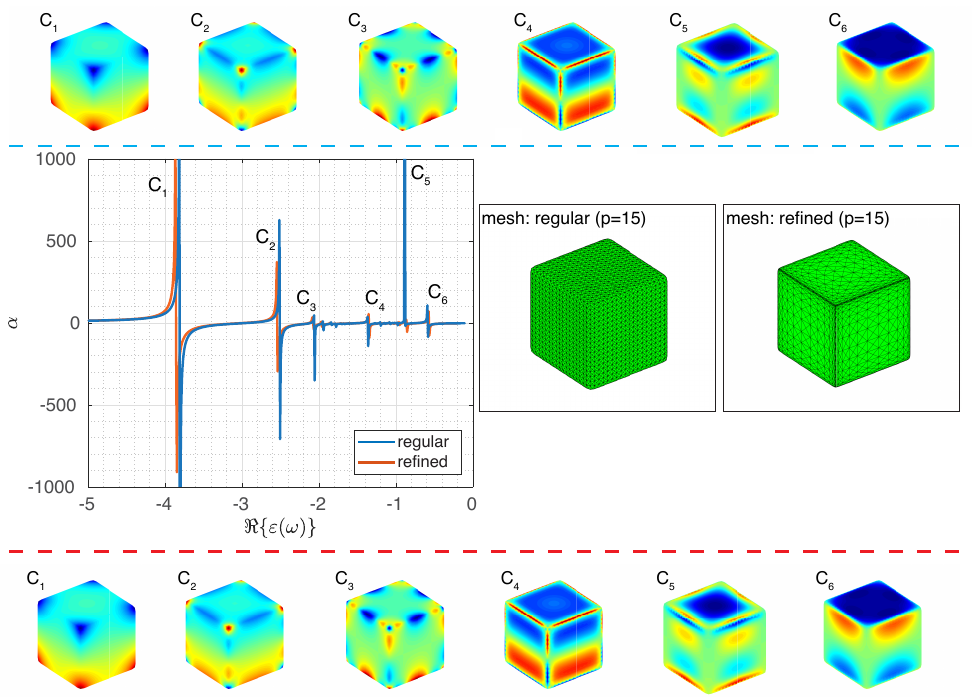
Figure 2. The absolute value of the polarizability at the ε ∈ [ − 5,0 ] domain of a smooth cube with p = 15. The color figures at the top color depict the surface potential of the six most pronounced resonances C 1 – C 6 , for the regular mesh, while at the bottom the same surface potential are shown for the refined mesh. Blue and red colors indicate negative and positive values of the potential. The inset figure illustrates the used meshes, i.e., regular and refined